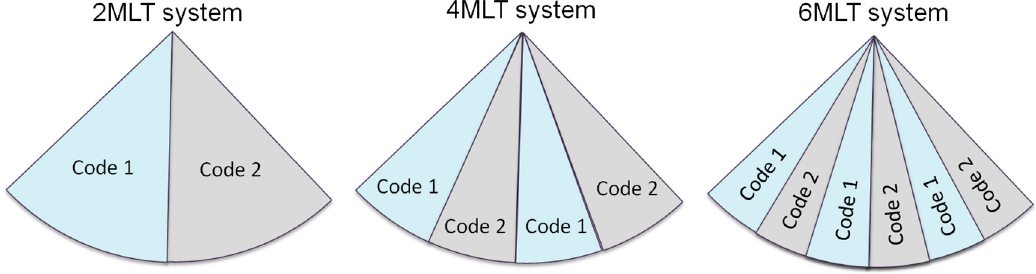
Figure 5. Illustration of the interleaving arrangement of two orthogonal codes on a given MLT imaging scheme. Code 1 and code 2 are mutual orthogonal codes.